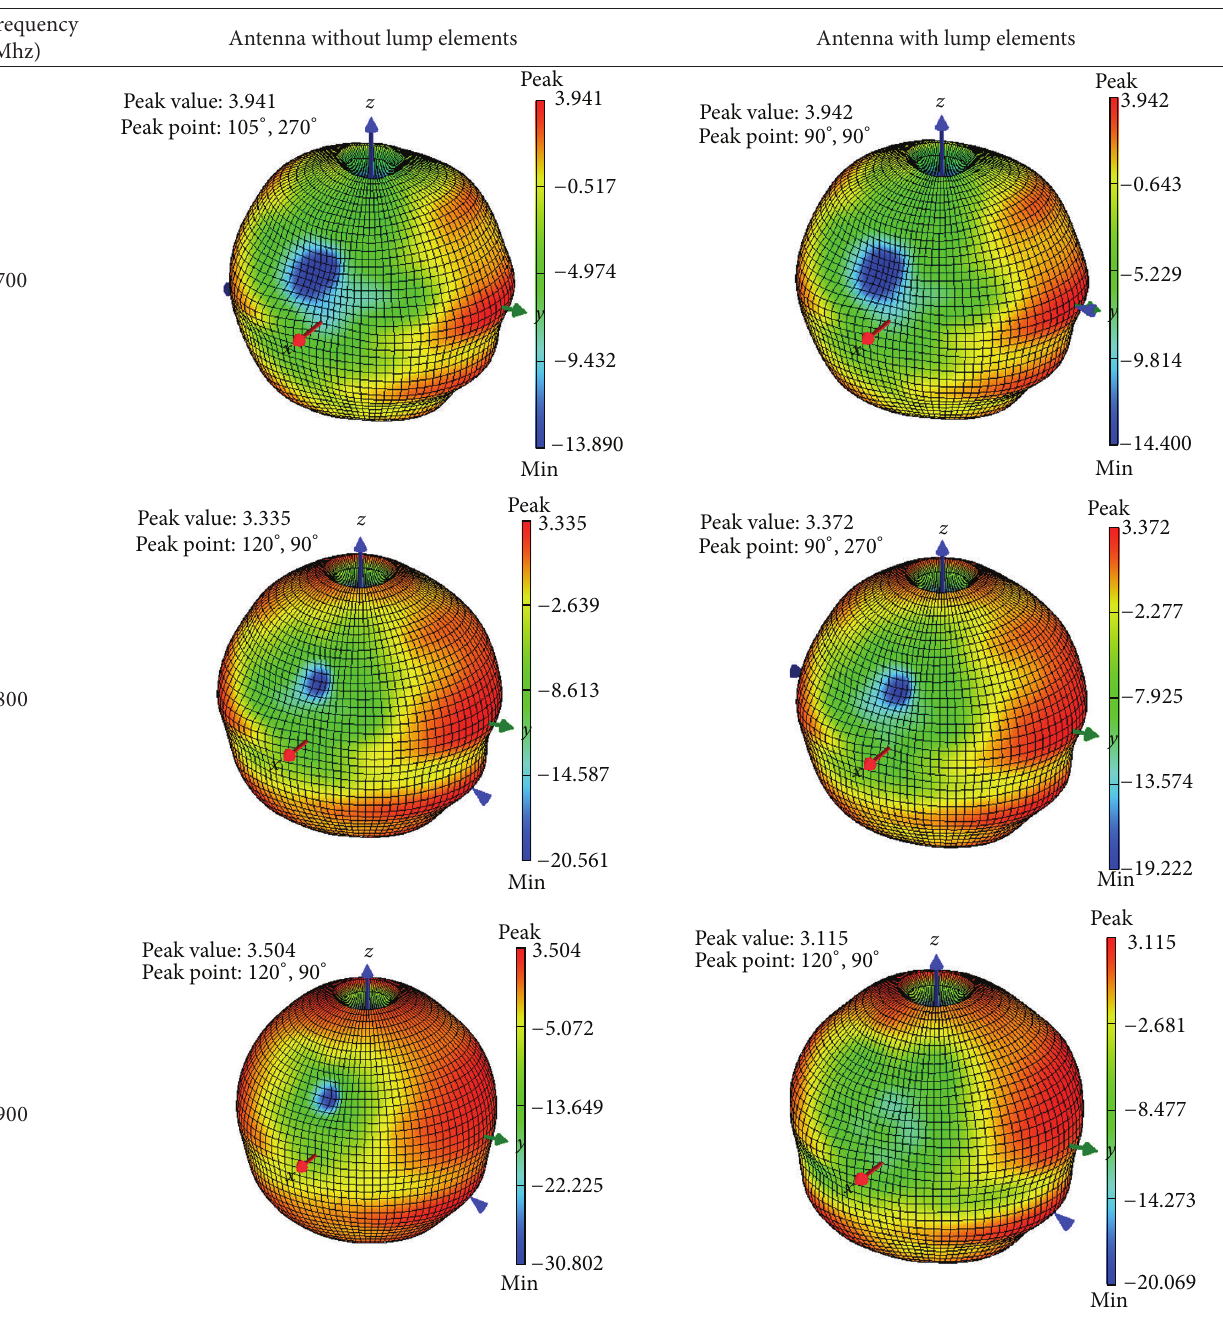
Table 1: 3D radiation pattern measurement results of the antenna without and with lump